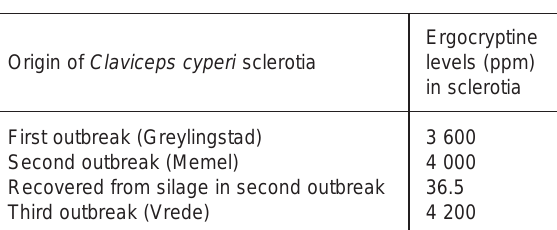
TABLE 3 Ergocryptine levels of sclerotia collected in maize lands in 1997(note that levels are, in contrast to all the other chemical determinations mentioned, given in ppm and not ppb